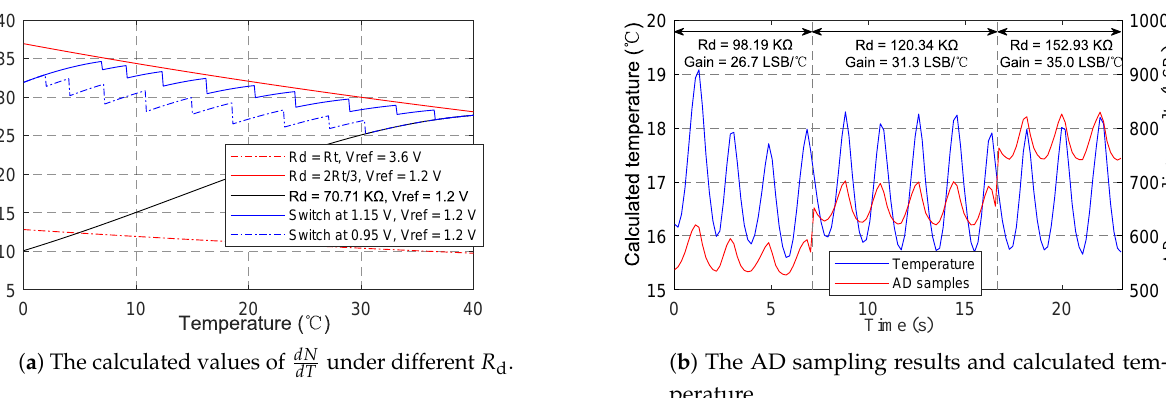
constant R d (70.71 K Ω ) at 17 ◦ C is only 18.9 LSB/ ◦ C, and the gain may further decrease with the decrease in temperature.